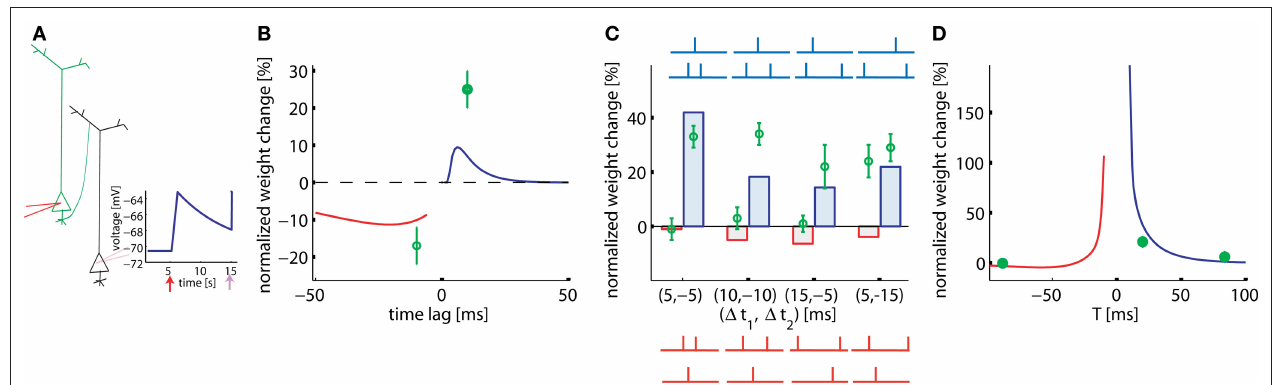
schematics). The four different post-pre-post triplets are: (a) post-5ms-pre-5ms- FigurE 6 | Pairs, triplets, and quadruplets of spikes in cultured post, (b) post-10ms-pre-10ms-post, (c) post-5ms-pre-15ms-post, and (d) hippocampal neurons. (A) Intracellular presynaptic stimulation results in a post-15ms-pre-5ms-post. The four different pre-post-pre triplets are: (a) model EPSP of 7.5 mV (schematic). (B) STDP function in the pair-experiment. pre-5ms-post-5ms-pre, (b) pre-10ms-post-10ms-pre, (c) pre-15ms-post-5ms- (C) Triplet experiments. ∆ t in the post-pre-post configuration is the time 1,2 pre, and (d) pre-5ms-post-15ms-pre. Lines and bars: simulations. Green between the single pre- and the two postsynaptic spikes (blue histogram bars circles: data redrawn from Wang et al. (2005). (D) Quadruplet experiment (see and schematics) or, in the pre-post-pre experiment the time between the main single post- and the two presynaptic spikes (red histogram bars and